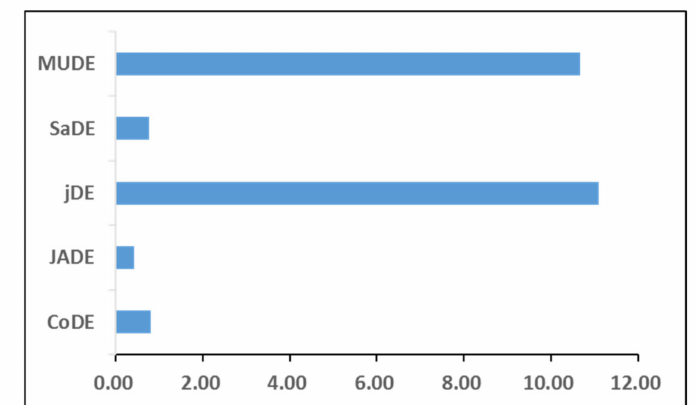
Figure 5. The total running time of 25 functions in different DE